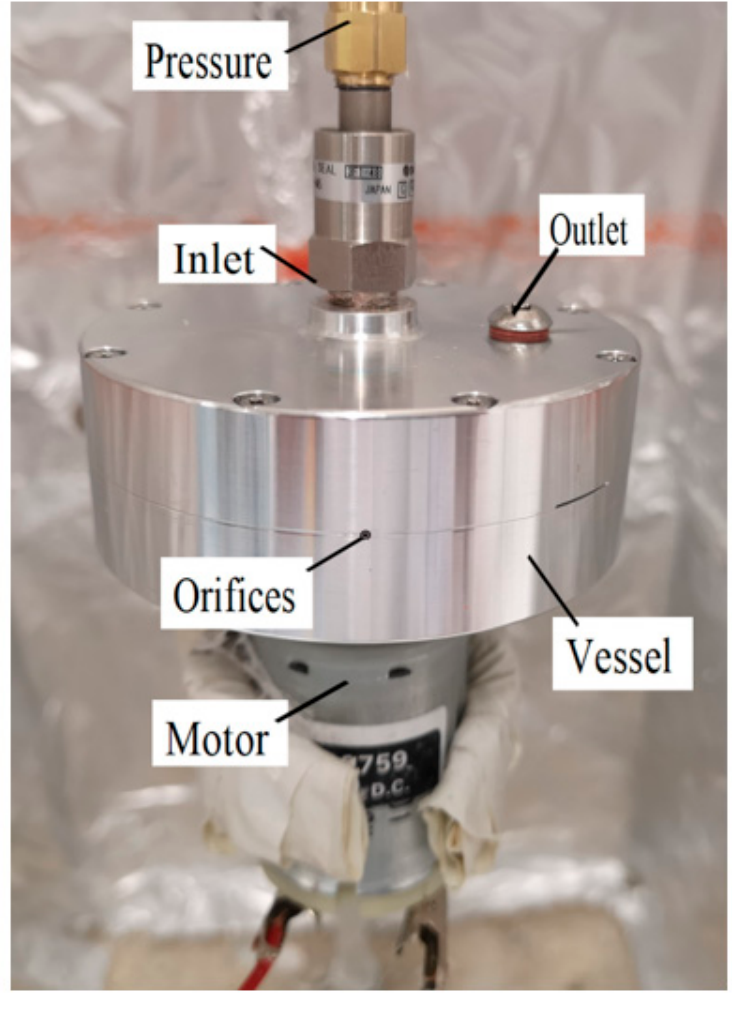
Figure 1. Pressurised gyration set-up.